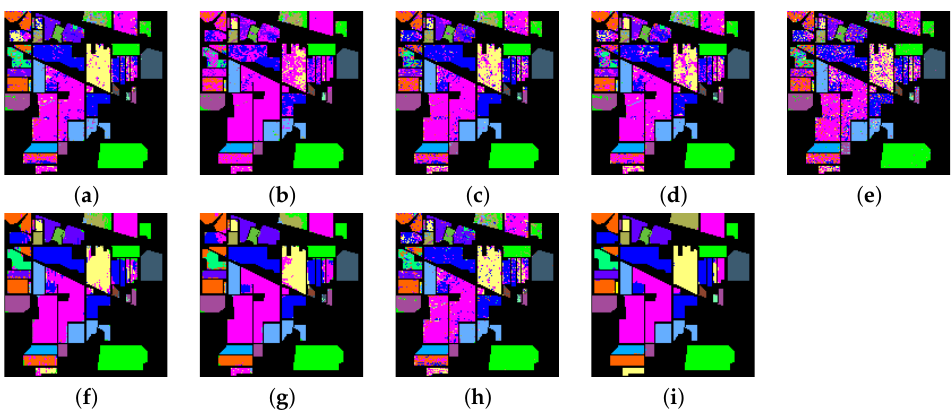
Figure 6. Classification maps for the Indian Pines data set using the compared methods and the proposed method. ( a ) SVM; ( b ) NRS; ( c ) CRT; ( d ) KCRC; ( e ) OMP; ( f ) SOMP; ( g ) JRSRC; ( h ) 3D-CNN; ( i ) SFL.